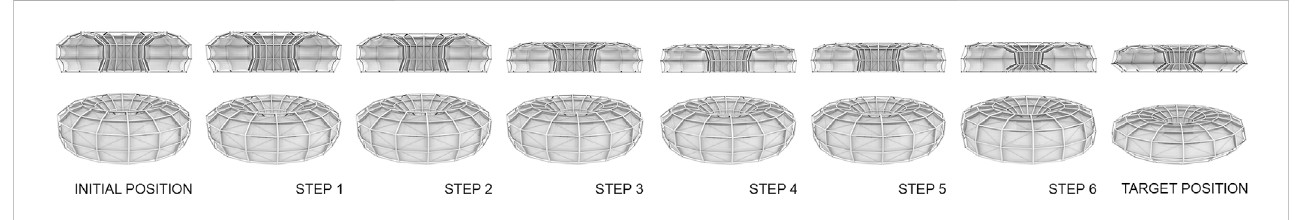
FIGURE 5 Parametric associative design of the transformable building based on the ECS and E4B